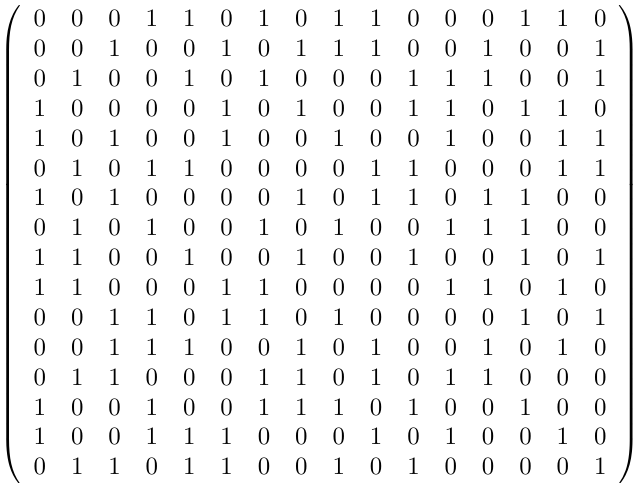
Figure 3: Aria diffusion layer